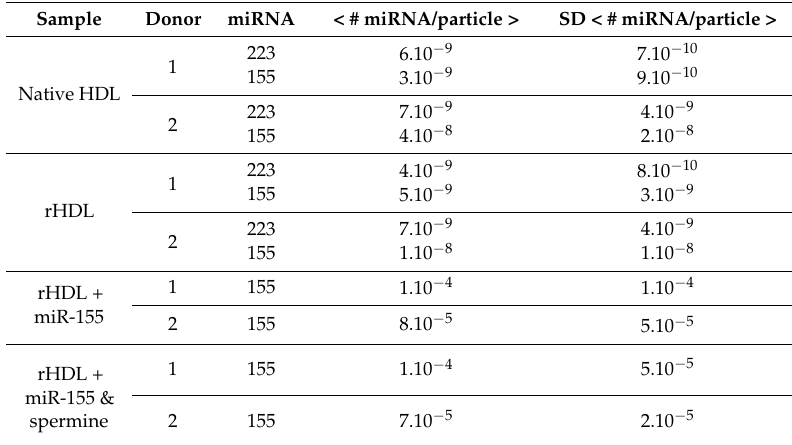
Table 2. * miRNA content of HDL particle variants.